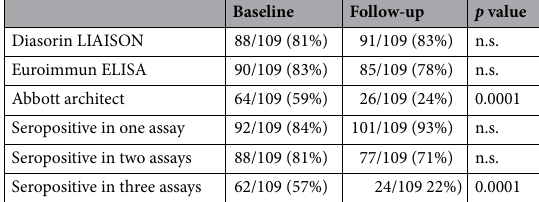
Table 2. Seroprevalence: comparison of assays between baseline and follow-up. n.s. not